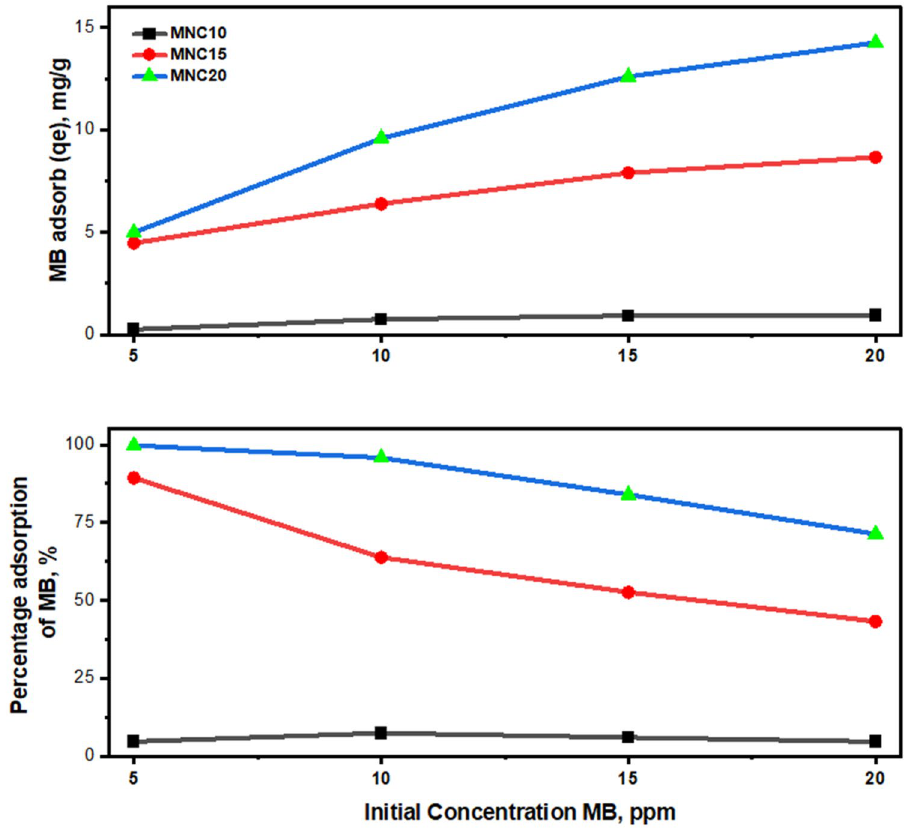
Figure 6. MB adsorption capacity (mg/g) and percentage of MB removal for MNC10-MNC20.